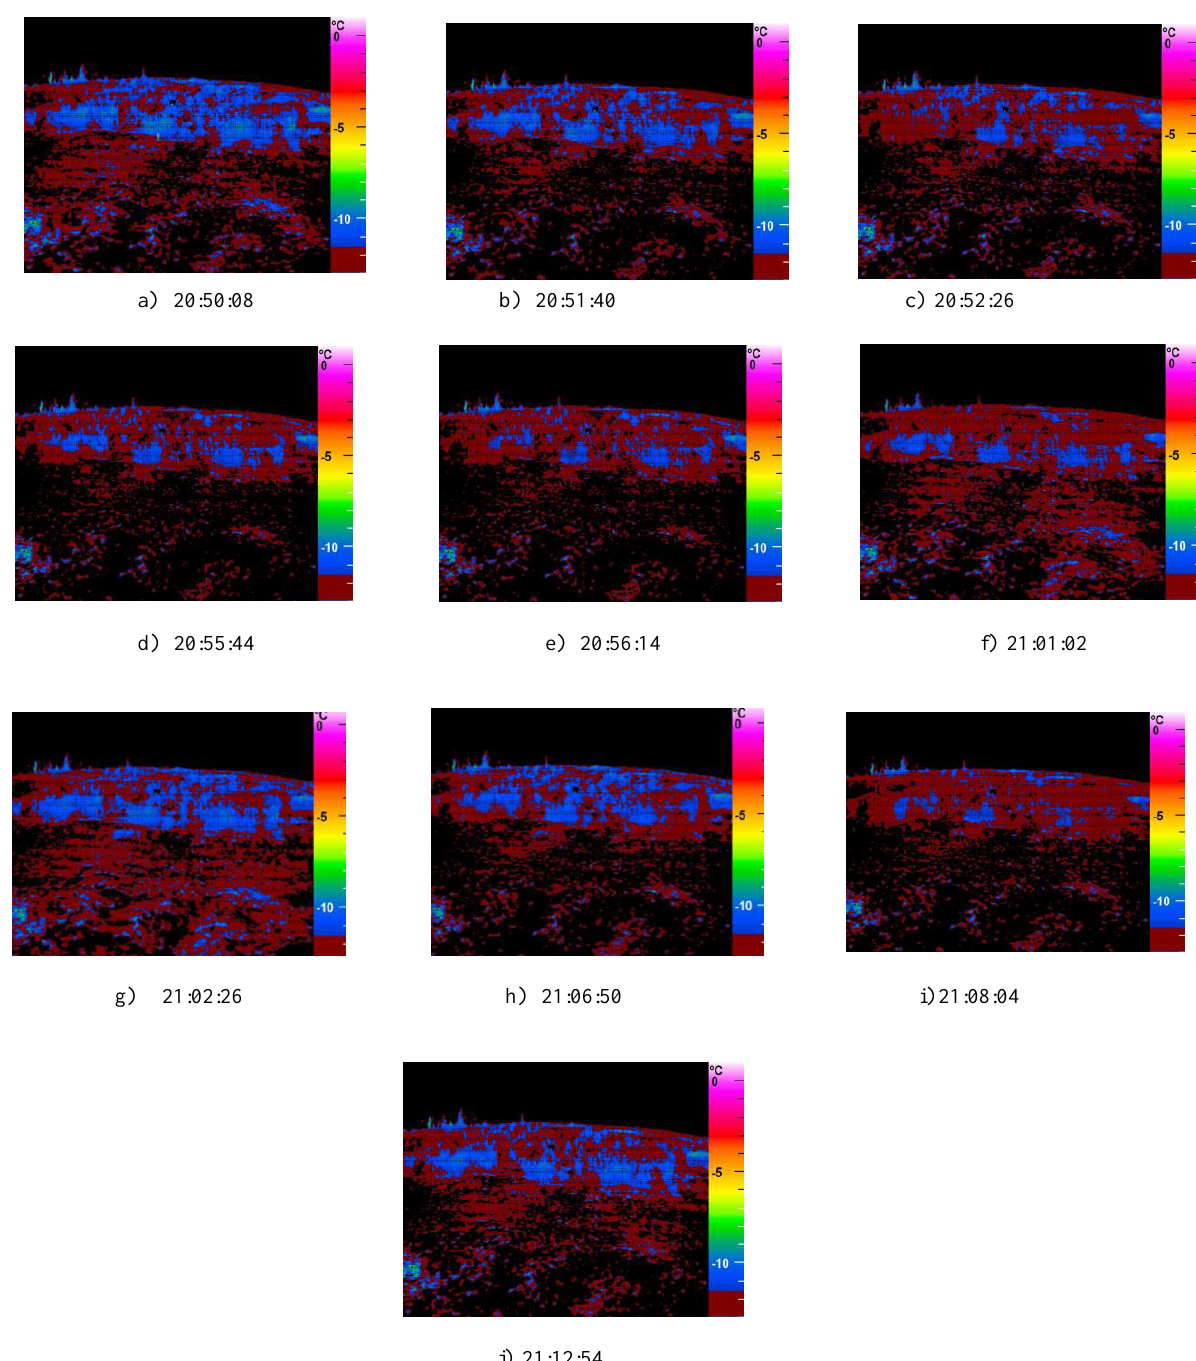
Figure 4. (a,b,c…j) illustrated periodic aspect of cold air drainage over the slope .for example at 21:2:26 there is no drainage (blue color) ,at 21:8:04 slope is cover by darniage (red